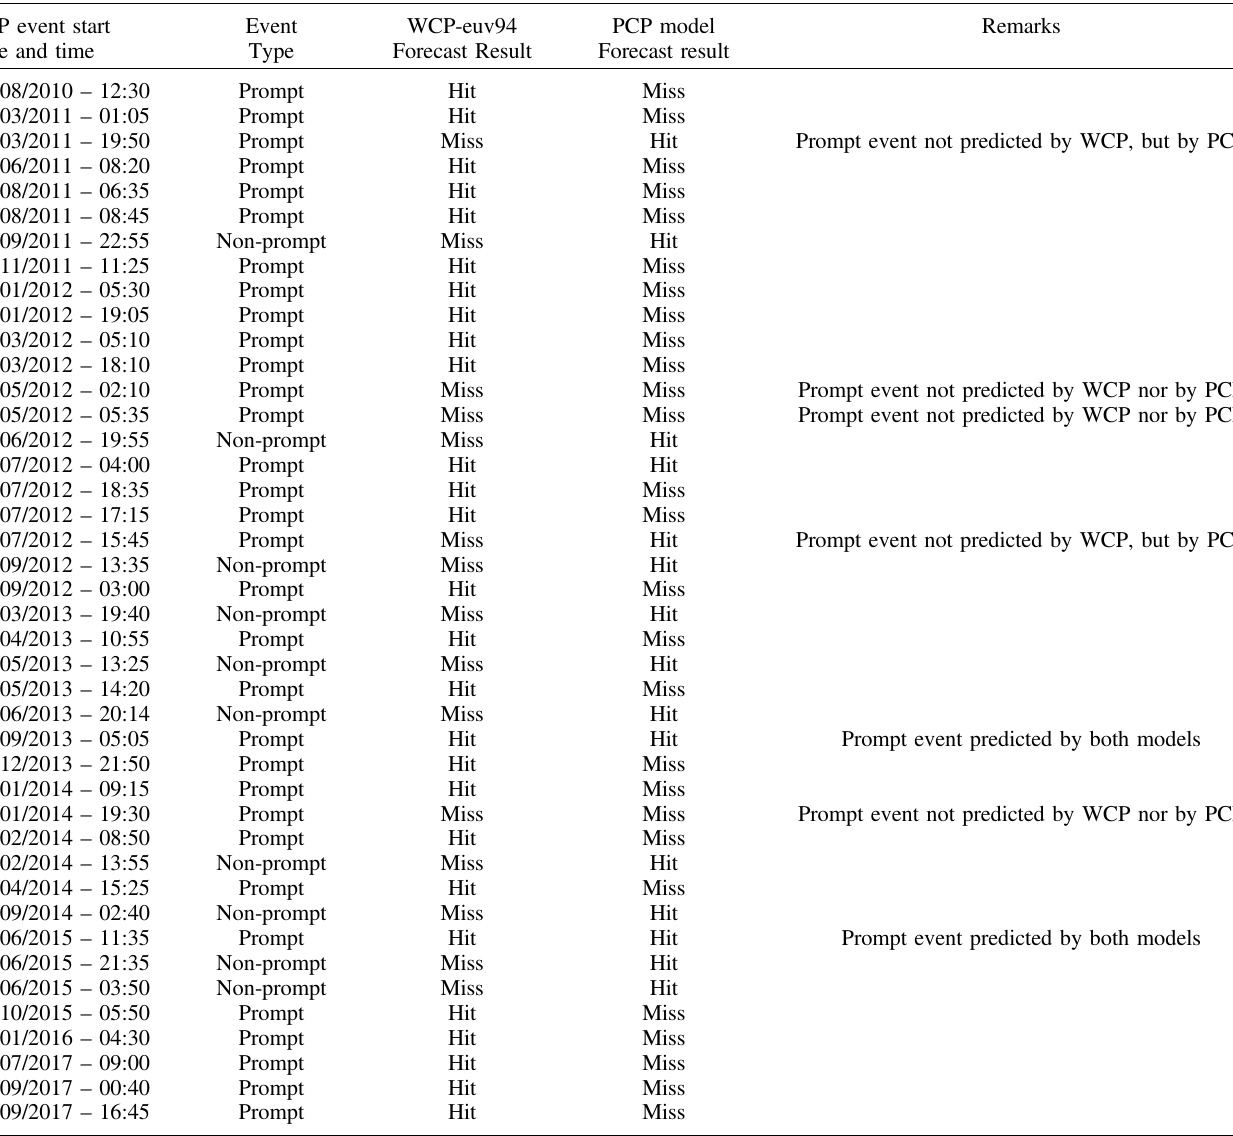
Table 5. Forecasting results of the PCP model, compared with those of the WCP-94, for predicting all >10 MeV SEP events that occurred from May 2010 to December 2017. The last column emphasizes which SEP events are predicted by both WCP-euv94 and PCP models and which by